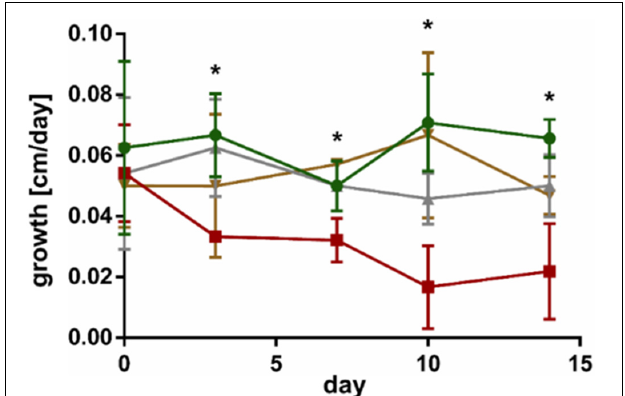
FIGURE 2 | Growth of L. digitata without GG pre-treatment in control conditions (green) and in co-cultivation with L. elsbetiae (red) and of L. digitata with GG pre-treatment in control conditions (gray) and with L. elsbetiae (gold). Significant differences are indicated by asterisks (see Supplementary Table 2 ). The presented values are mean values with standard deviation ( N = 4).